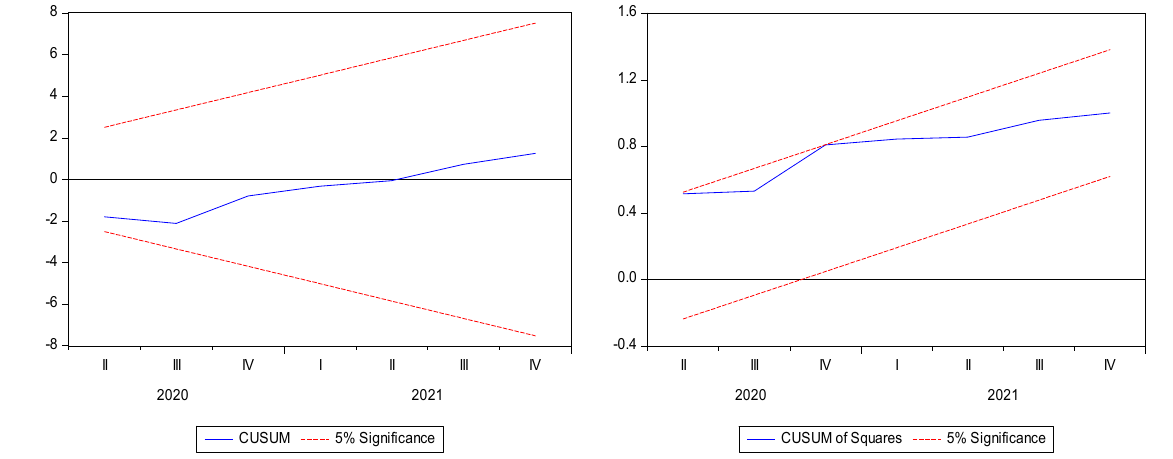
Fig. 3. CUSUM and CUSUM square test of EN  Tr in ARDL model.